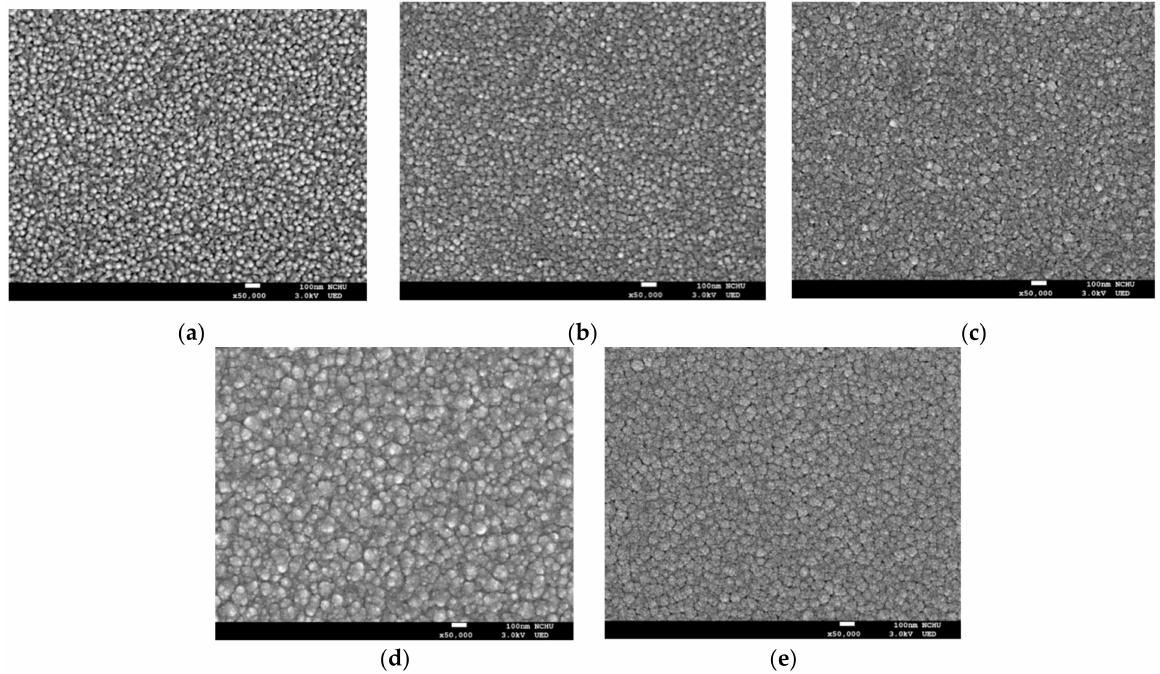
Figure 5. SEM images of ( a ) ZnO and MIPEMOCVD-grown GZO thin films with ( b ) 1.95, ( c ) 3.01, ( d ) 4.52, and ( e ) 5.42 at%